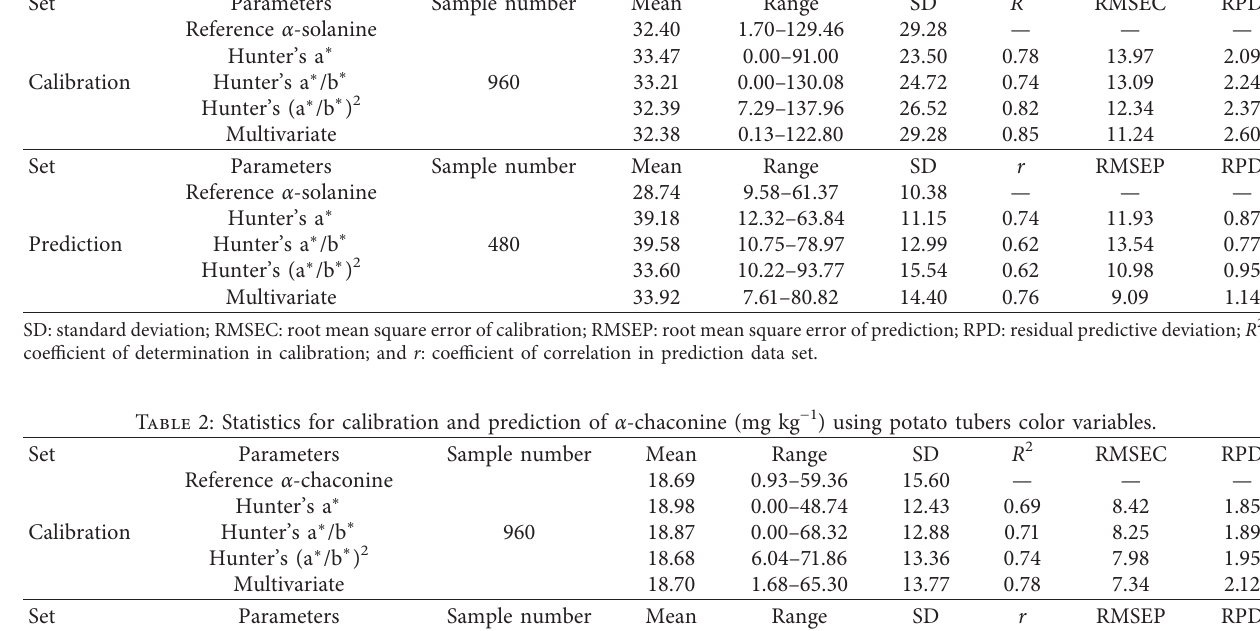
Table 1: Statistics for calibration and prediction of α -solanine (mg kg − 1 ) using potato tubers color variables. Set